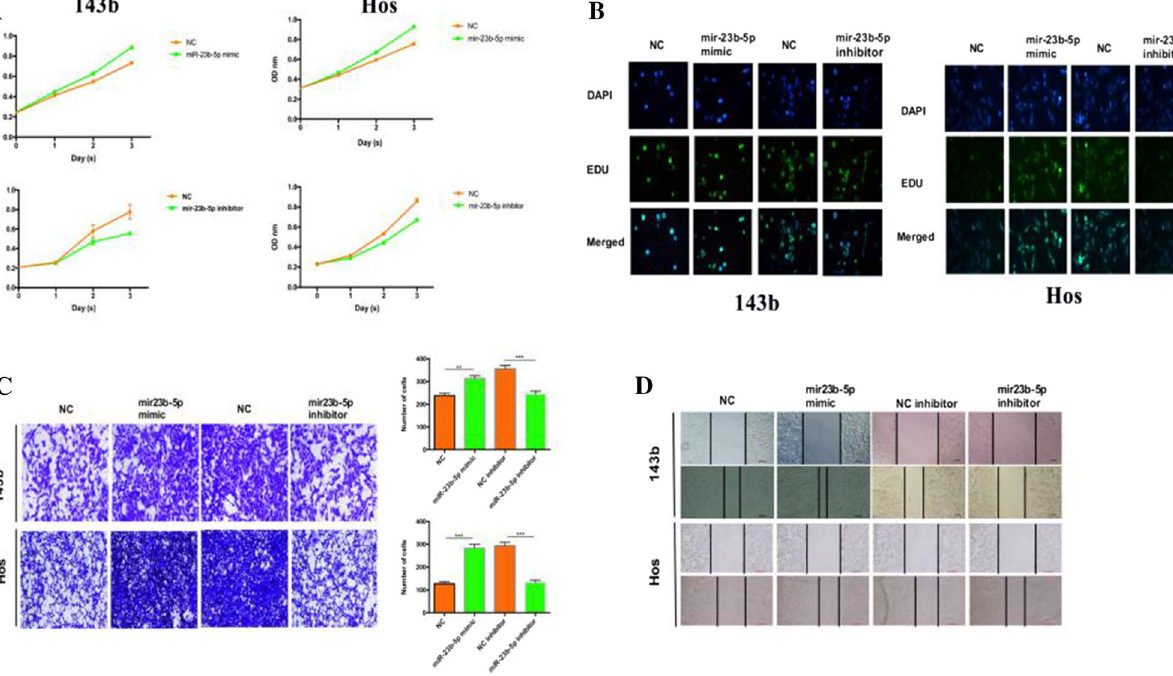
Fig. 2 miR-23b-5p promotes proliferation, migration and invasion of osteosarcoma cells. Cell biological functions were assessed by transfec- tion of OS cell lines with miR-23b-5p mimic or inhibitors. A Cell viability of 143b and Hos after miR-23b-5p mimic/inhibitor was detected by CCK-8 assay. B Cell proliferation kit to detect OS cell proliferation changes. C Transwell assay to detect the invasive ability of OS cells. D Anal- ysis of OS cell migration ability by wound healing assay. Results are shown as mean ± SD from three independent experiments. **P <